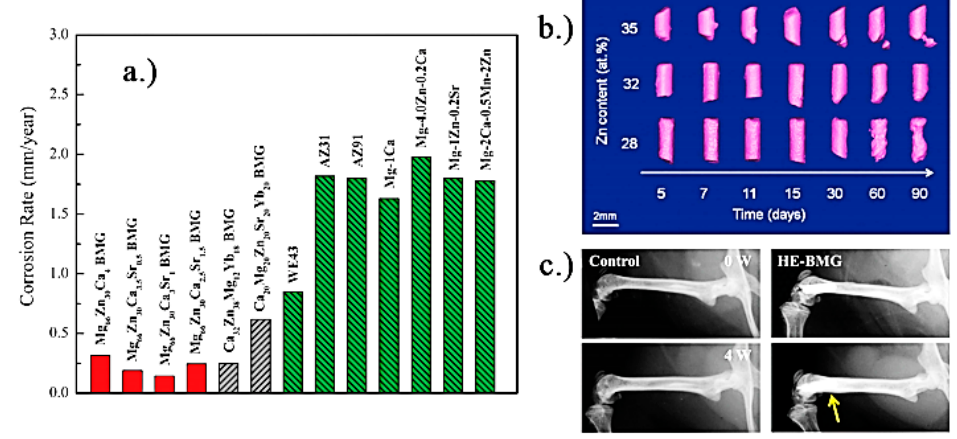
Figure 1. ( a ) Corrosion rates of Mg-based alloys in physiologically relevant solutions [12]; ( b ) Images of Mg95–xZnxCa5 (at %) implanted in rat femurs, reconstructed from in vivo μ -CT scans. Note visible degradation after 30 days for the x = 28 sample, while minimal and no degradation are visible on the x = 32 and x = 35 samples, respectively [13]; ( c ) Radiographs of mice distal femora with and without implanted high-entropy CaMgZnSrYb alloy, immediately after implantation, and 4 weeks postoperatively. The sample shows no gas formation, no inflammation, and enhanced circumferential osteogenesis in the implanted bone (yellow arrow), indicating new bone formation [14]. Reproduced with permission from [14,15].